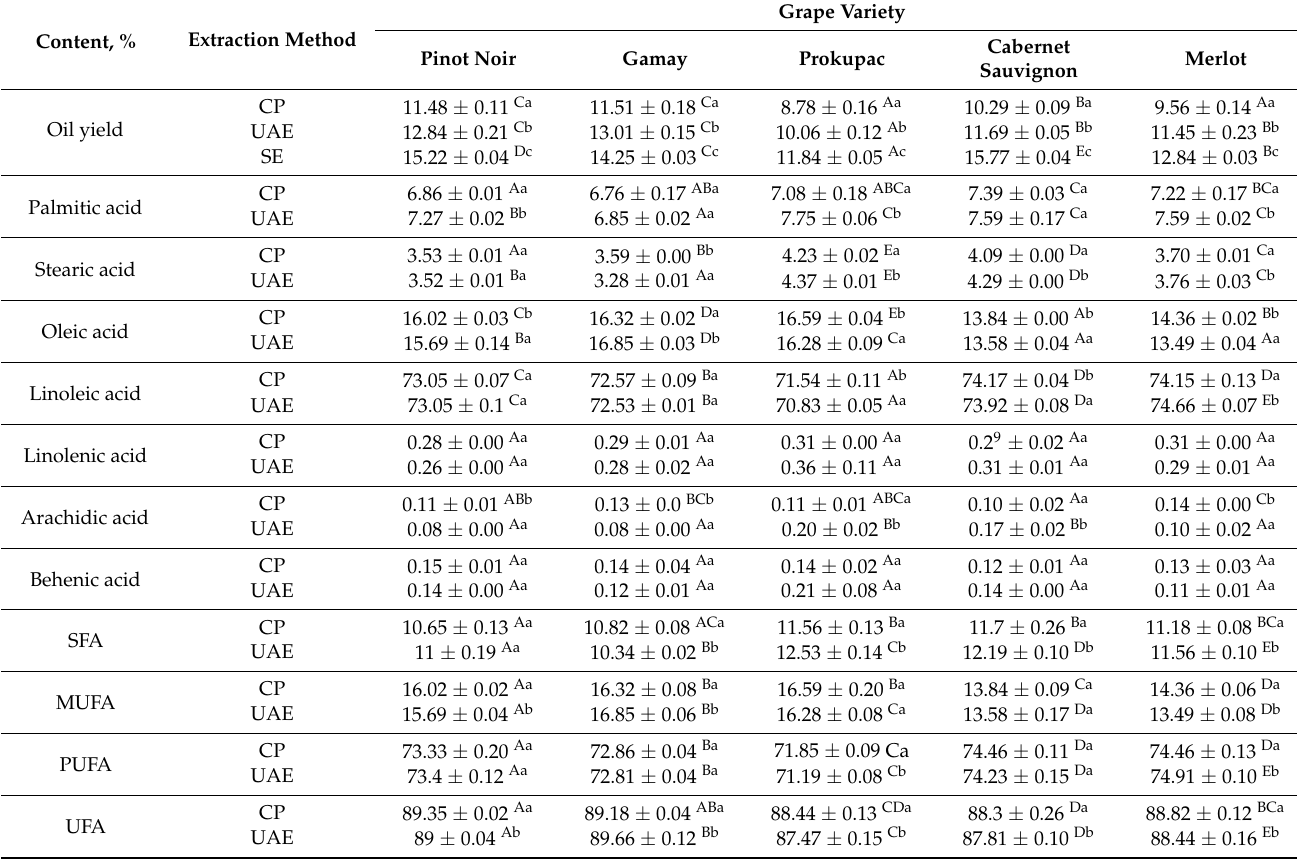
Table 2. Yield and fatty acid composition of analyzed grape seed